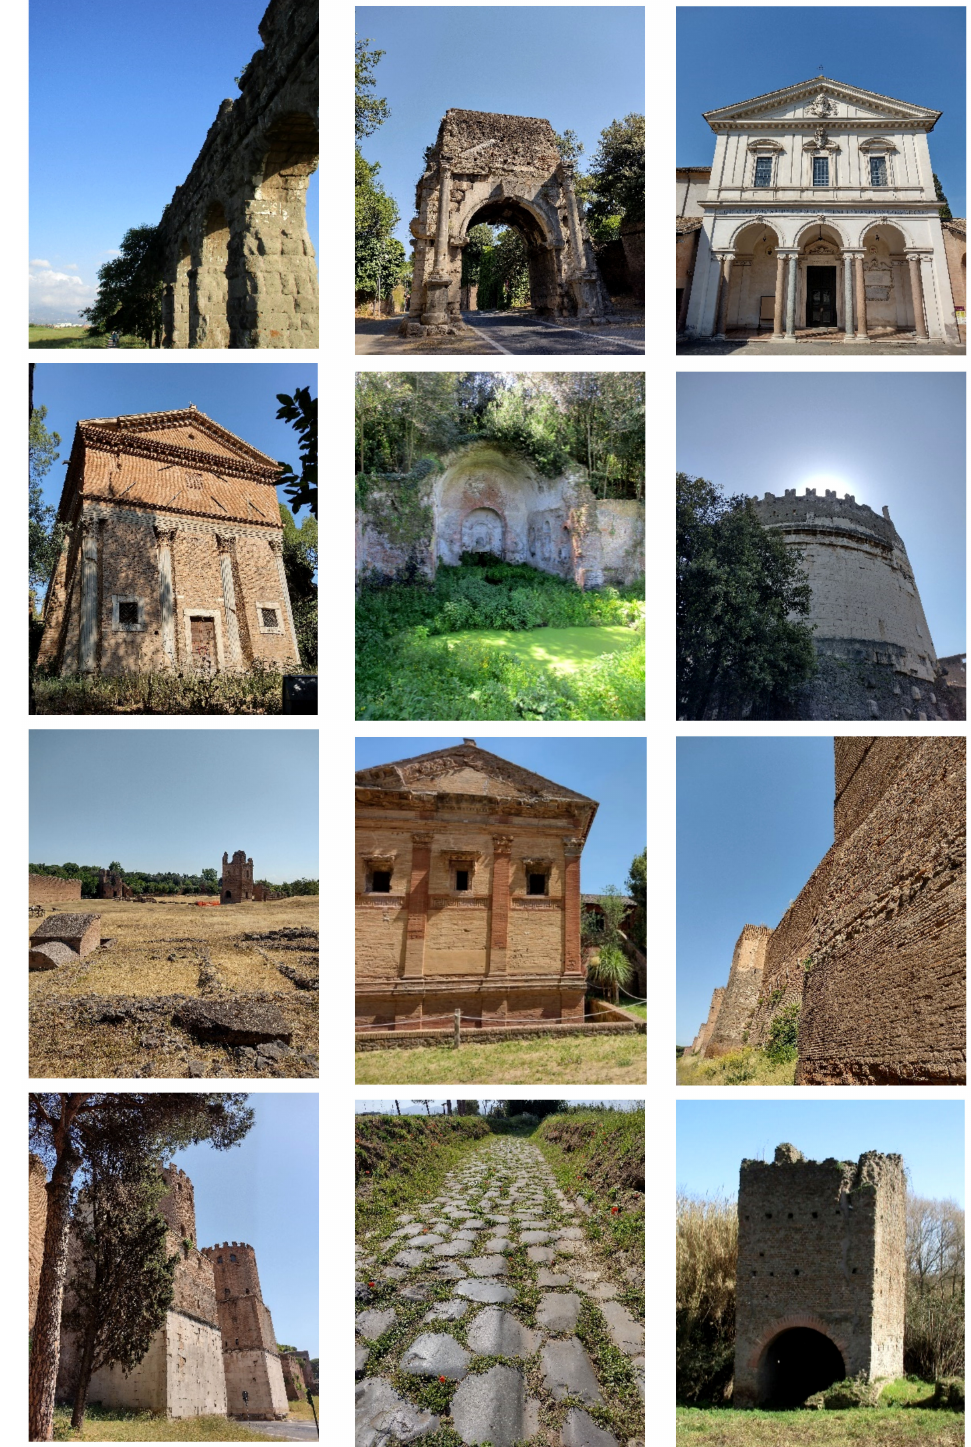
Figure 15. Archeological elements of Appia Antica Regional Park landscape. First row (from left to right): Aqua Claudia aqueduct; Druso ’s Arch ( Antoniano aqueduct); catacomb San Sebastiano (entrance). Second row: church Sant’Urbano ; Egeria nymphaeum; Cecilia Metella sepulcher. Third row: Massenzio ruins; temple of God Redicolo ; Aureliane ’s wall. Fourth row: San Sebastiano ’s door; Latina way; medieval tower Valca